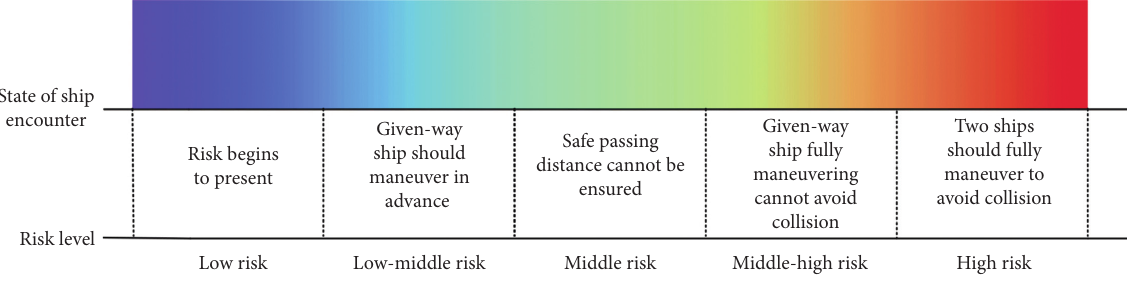
Figure 1: Spectrum of the collision risk Table 1: Confusion matrix for prediction result of risk level.